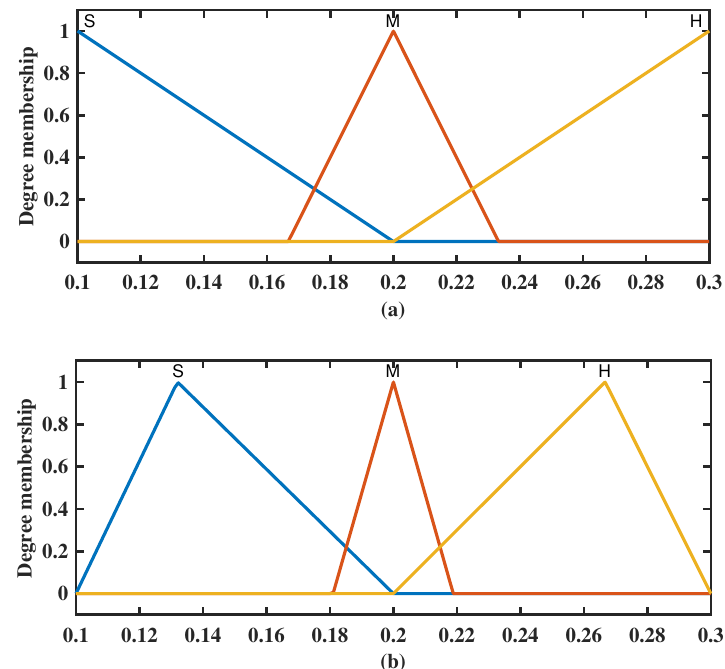
Figure 7. Membership functions of output parameters ( a ) Membership function of β ; ( b ) Membership function of γ .